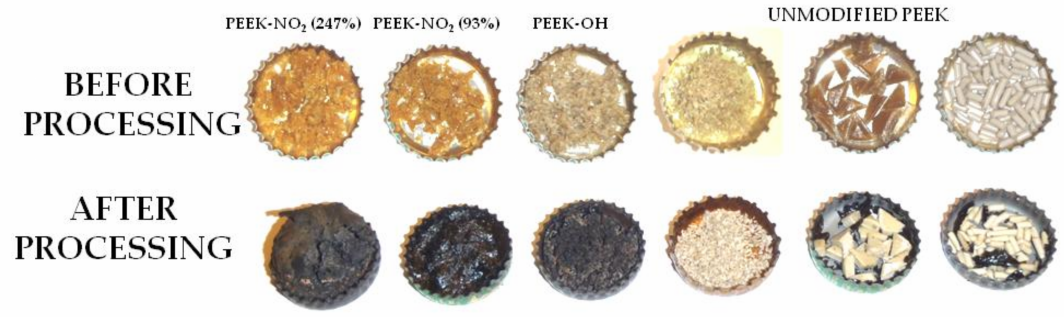
Figure 11. Results of thermal treatment of the obtained PEEK modification